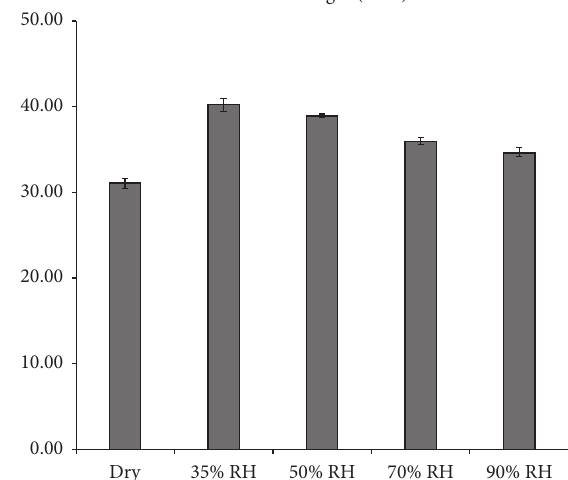
Figure 3: Shear strength of the flax/epoxy composite